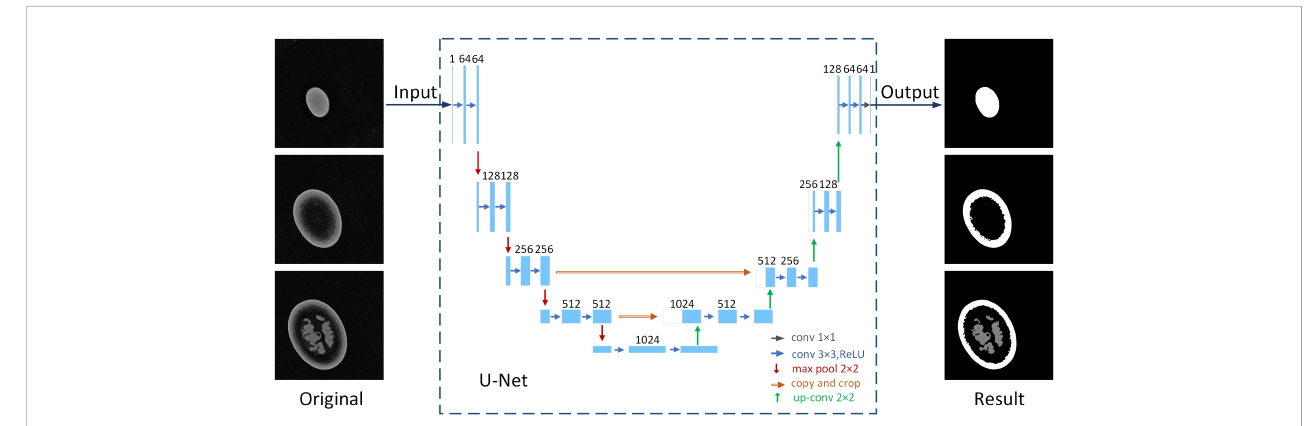
FIGURE 6 Application of U-Net convolutional model in tomogram image segmentation.